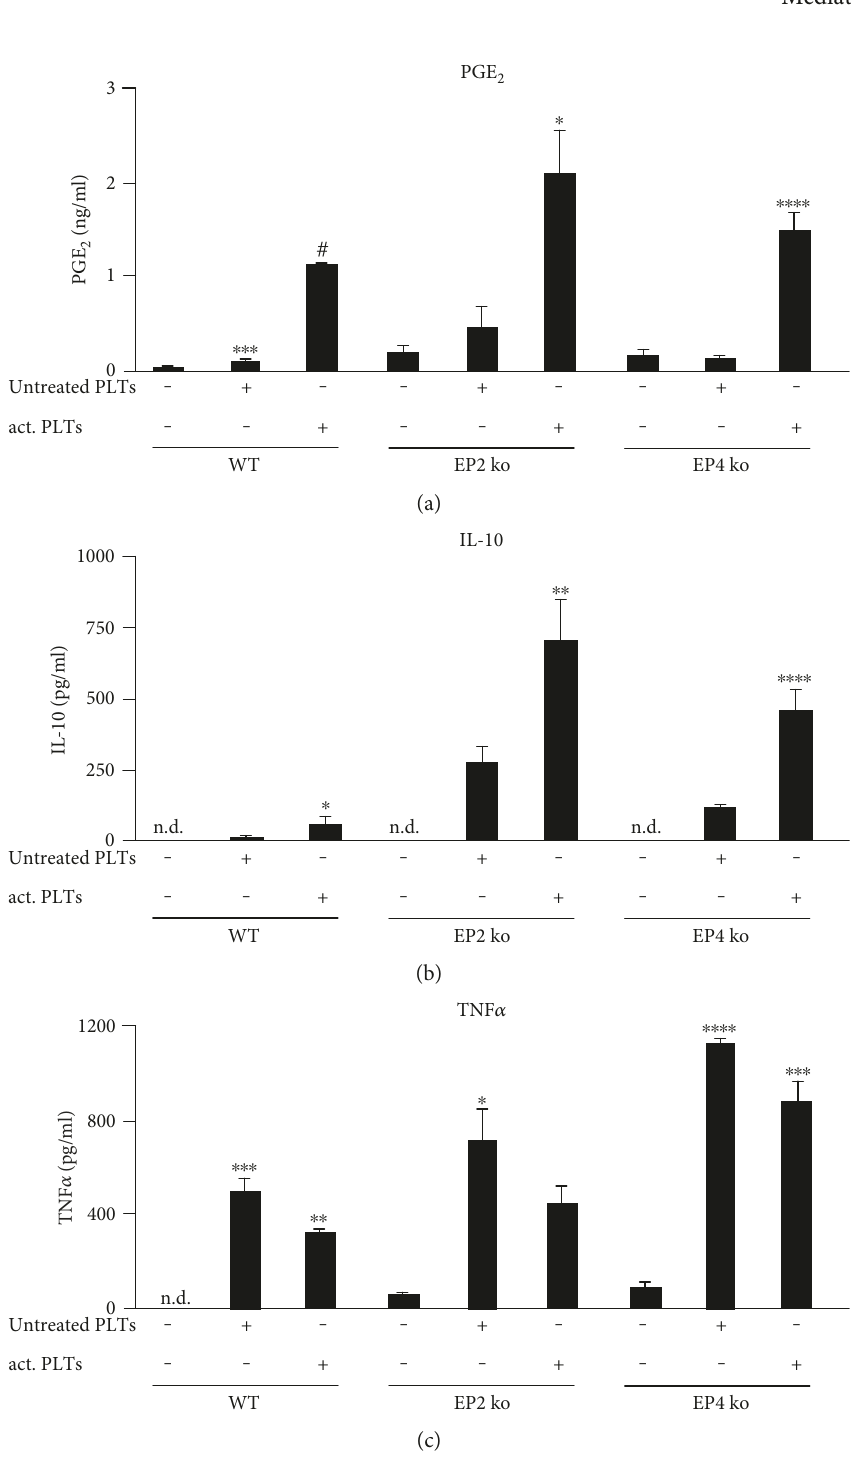
and IL-10 and TNF α released from EP2- and EP4-de fi cient 2 (a) were 2